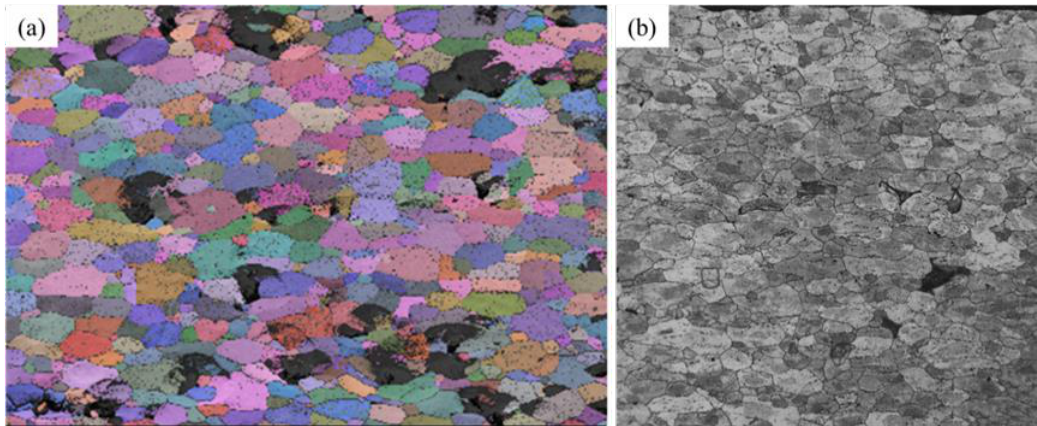
Figure 8. The cavities occur during the superplastic deformation. ( a ) 3D-electron back scattering diffraction (EBSD) microstructure and ( b ) metallographic microstructure.